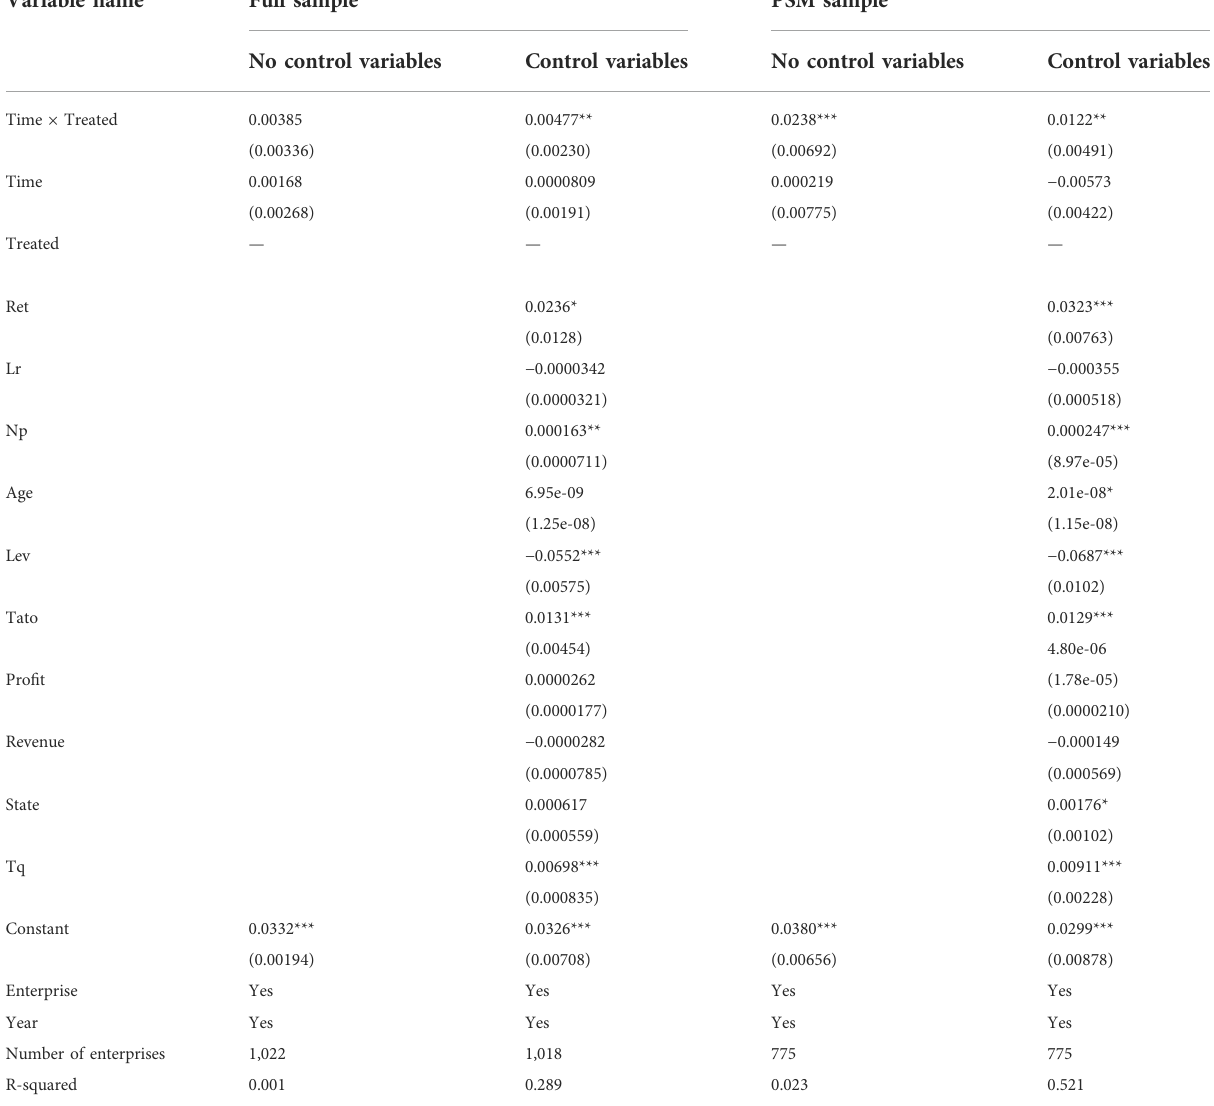
TABLE 4 A test of the impact of green credit policy on the fi nancial performance of construction energy-saving